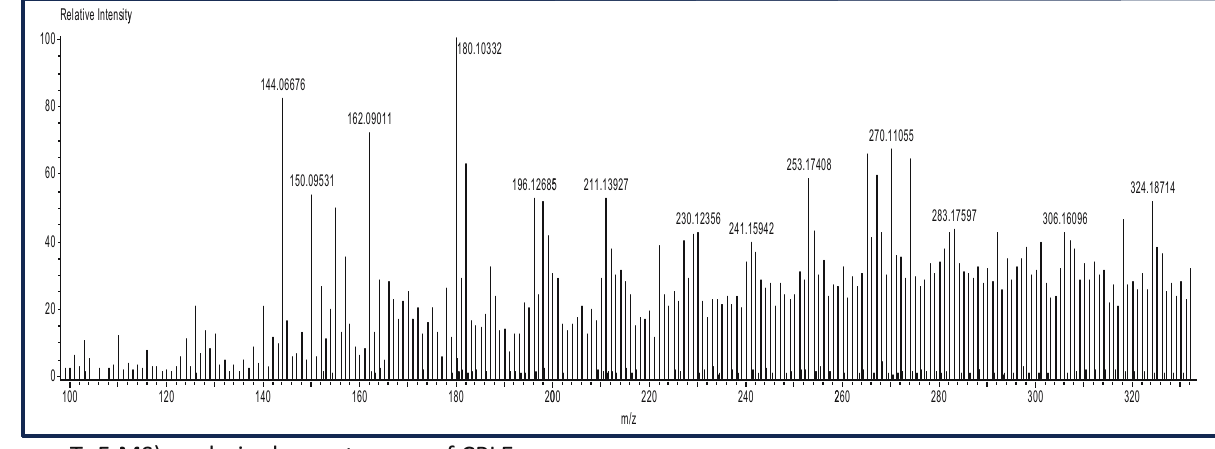
Figure 1: DART – ToF – MS analysis chromatogram of CPLE.